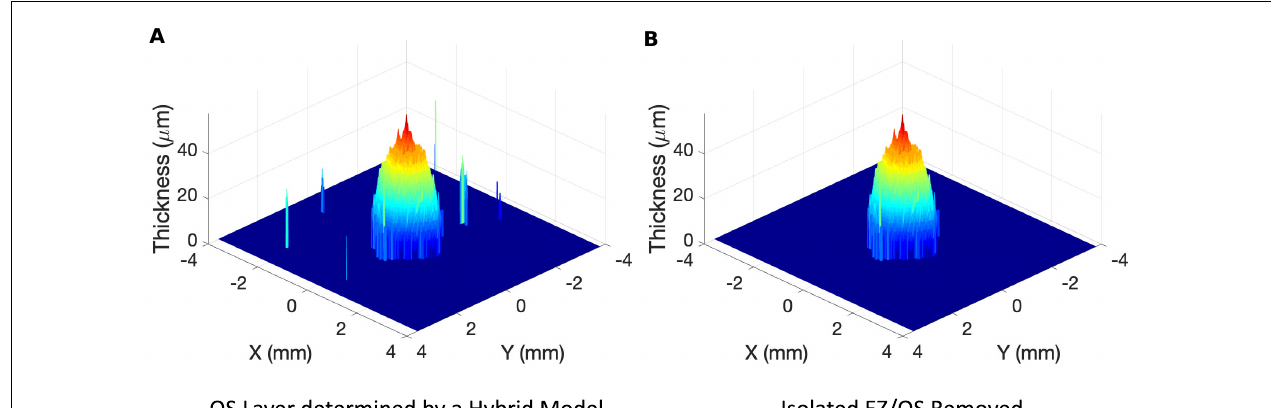
FIGURE 2 | Examples of 3-dimensional plot of photoreceptor outer segment (OS) layer from a 9-mm 121-line SD-OCT volume scan of a patient with retinitis pigmentosa. (A) OS layer determined by a hybrid deep learning model described in the method. (B) OS layer after off-center isolated local ellipsoid zone (EZ)/OS areas shown in panel (A) were removed.